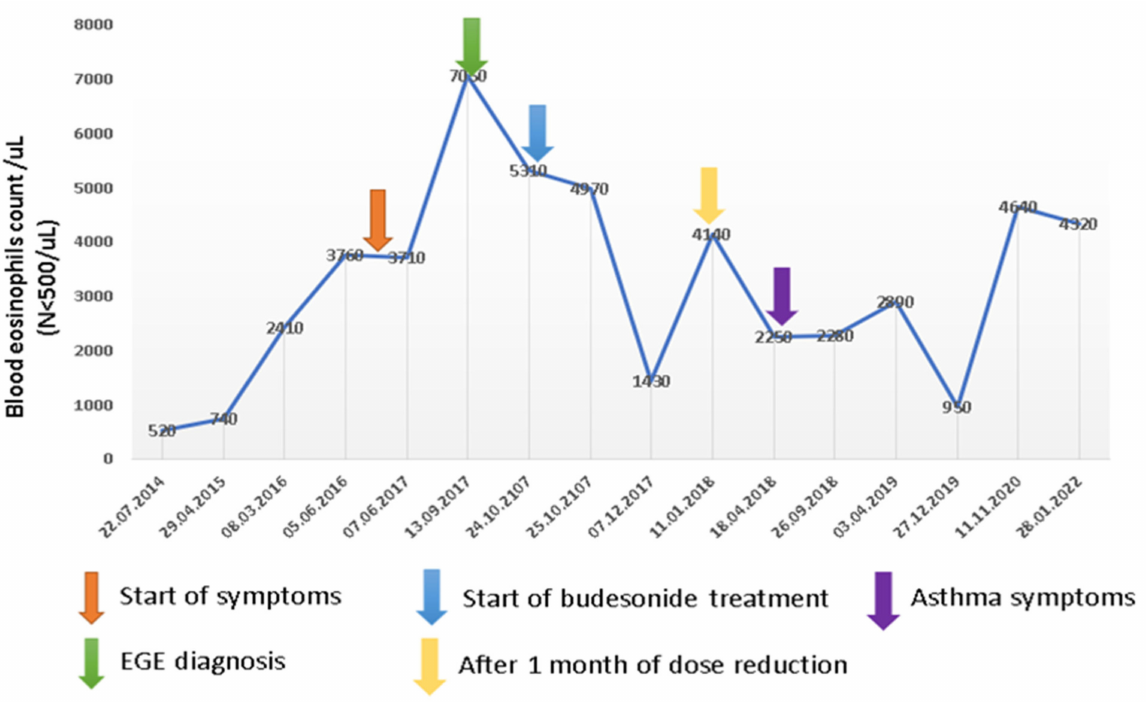
Figure 3. Blood eosinophilia level in